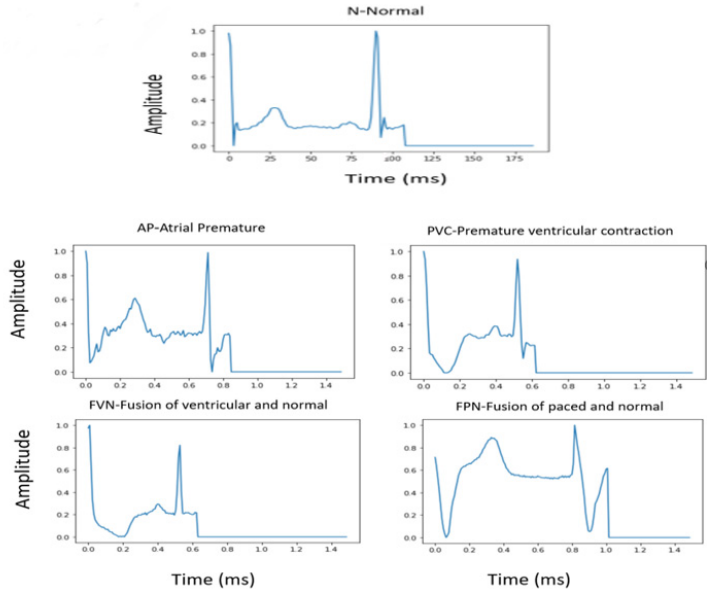
Figure 3. Sample plots of five different classes for MIT-BIH dataset.